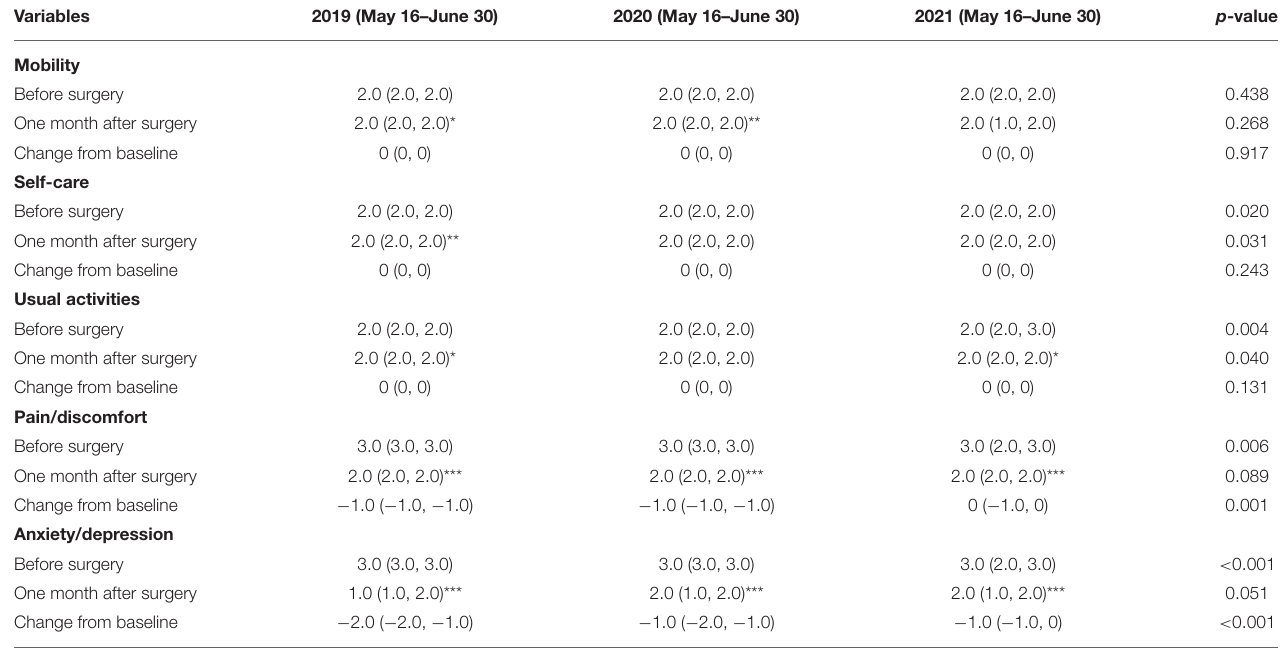
TABLE 4 | Original scores of the five dimensions of EQ-5D according to the year of surgery. Variables